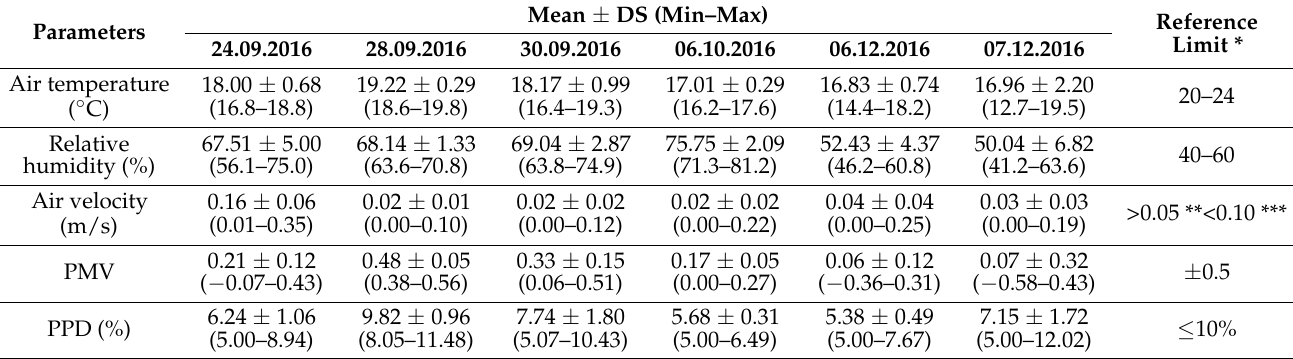
Table 2. Microclimatic values: PMV = presumed mean value; PPD = presumed percentage of dissatisfied. Parameters